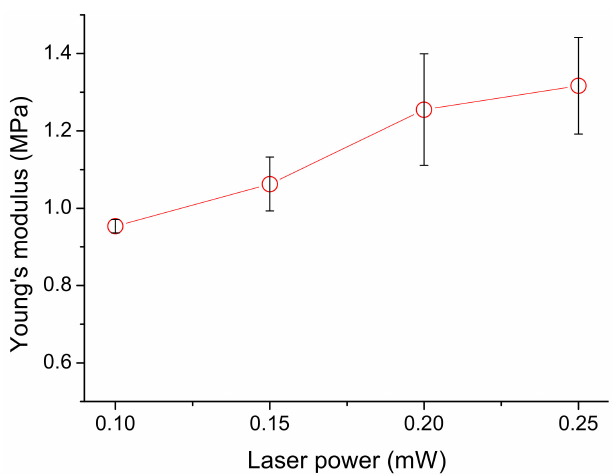
Figure 8. Variation of Young’s Modulus with laser power: Increasing the average laser power from 0.1 to 0.25 mW increased the Young’s modulus from ~965 kPa to ~1750 kPa. The circles represent data averaged from three specimens and the error bars indicate the standard deviation of